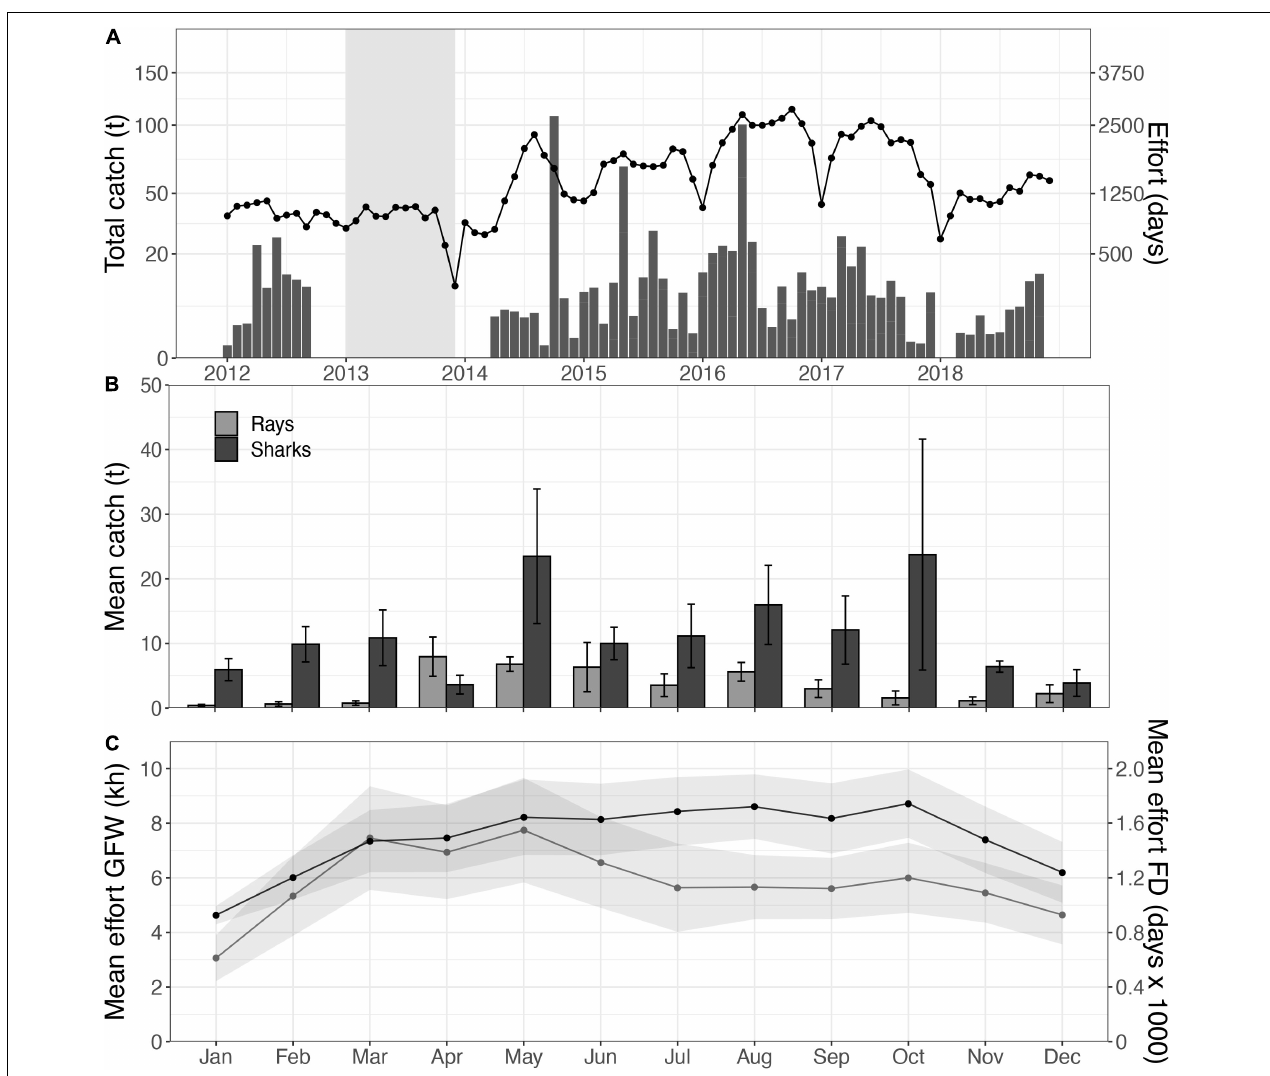
FIGURE 5 | Total elasmobranch catches (bars) and fishing effort (line) within the Guinea-Bissau EEZ, with no-data periods for elasmobranchs indicated in gray (A) , with a close-up of the monthly mean catches, separated for sharks (black) and rays (gray), over the 2014–2016 period (B) , in relation to fishing effort within the BA 2x buffer zone based on the AIS data (gray; in kh), and the total fishing effort in the EEZ of Guinea Bissau as reported by the fisheries institute (black; in fishing days, FD) (C)